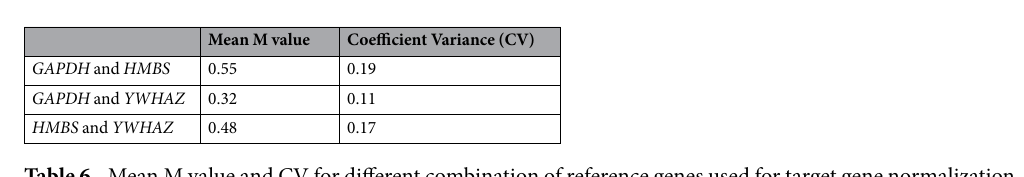
Table 6. Mean M value and CV for different combination of reference genes used for target gene normalization. Results from three biological replicates (n = 3). One biological replicate of each sample consisted of IEL-28.4 + cells harvested from 8